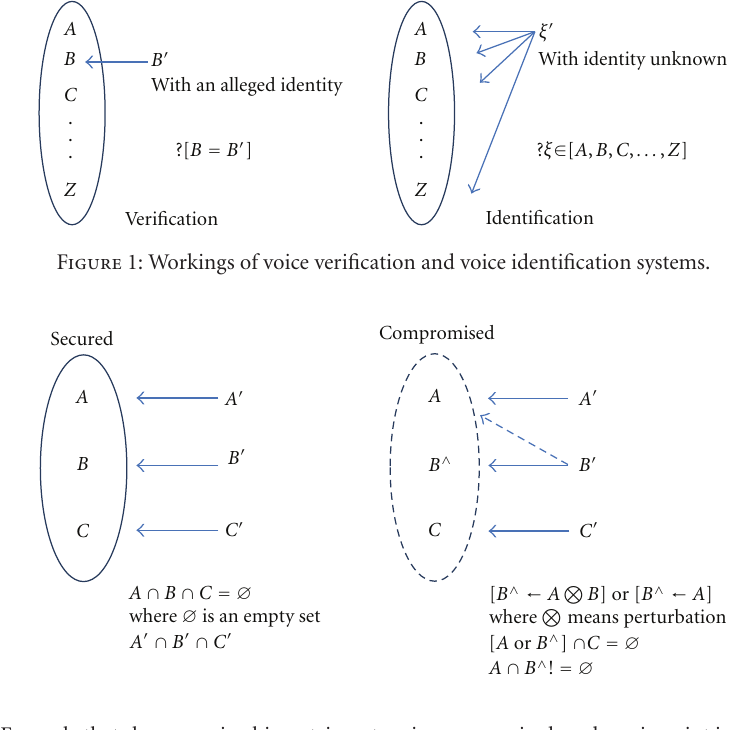
Figure 2: Example that shows a voice-biometric system is compromised, and a voiceprint is